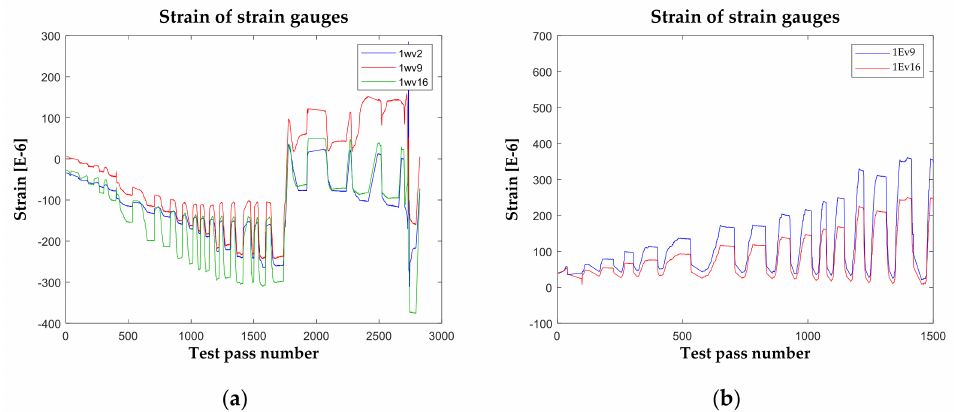
Figure 26. Strain of strain gauges: ( a ) strain of the strain gauges identified as1WV2, 1WV9 and 1WV16; ( b ) The charts of strain of the strain gauges identified as 1EV9 and